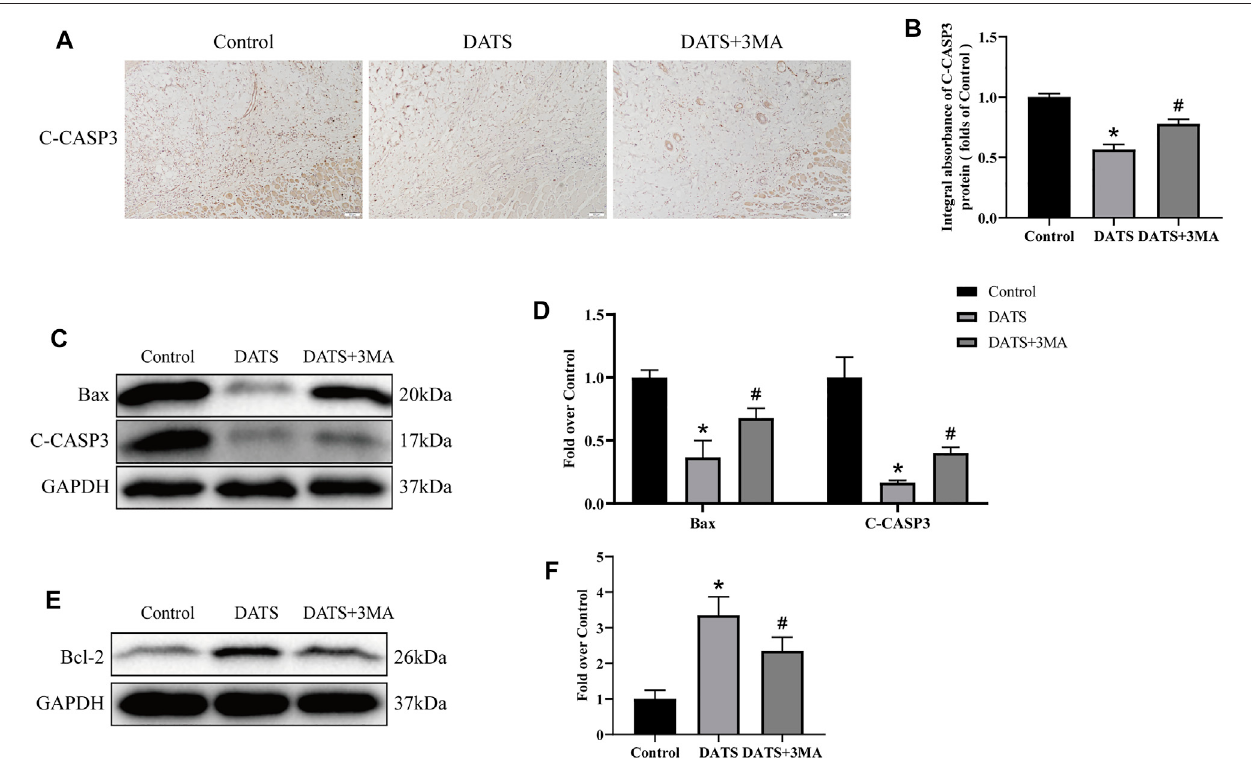
FIGURE6| DATS-induced autophagy affects apoptosis in the multiterritory perforator fl ap. (A) IHCfor C-CASP-3in themultiterritory perforator fl ap in each group (original magni fi cation ×200; scale bar, 50 μ m). (B) Statistical chart of the C-CASP-3 expression level estimated by IHC. (C) Western blotting of oxidative stress markers, C-CASP-3, and Bax in the control, DATS, and DATS+3MA groups. (D) Statistical chart of the quanti fi cation of C-CASP-3 and Bax expressions in the perforator fl aps. (E) Western blotting of oxidative stress markers and Bcl-2 in the control, DATS, and DATS+3MA groups. All the gel electrophoresis experiments were carried out under the same experimental conditions. (F) Statistical chart of the quanti fi cation of Bcl-2 expressions in the perforator fl aps. * p < 0.05, vs. control group; # p < 0.05, vs. DATS group. The obtained data were expressed as means ± SEM, n = 6 for every group. DATS, diallyl trisul fi de; IHC, immunohistochemistry.